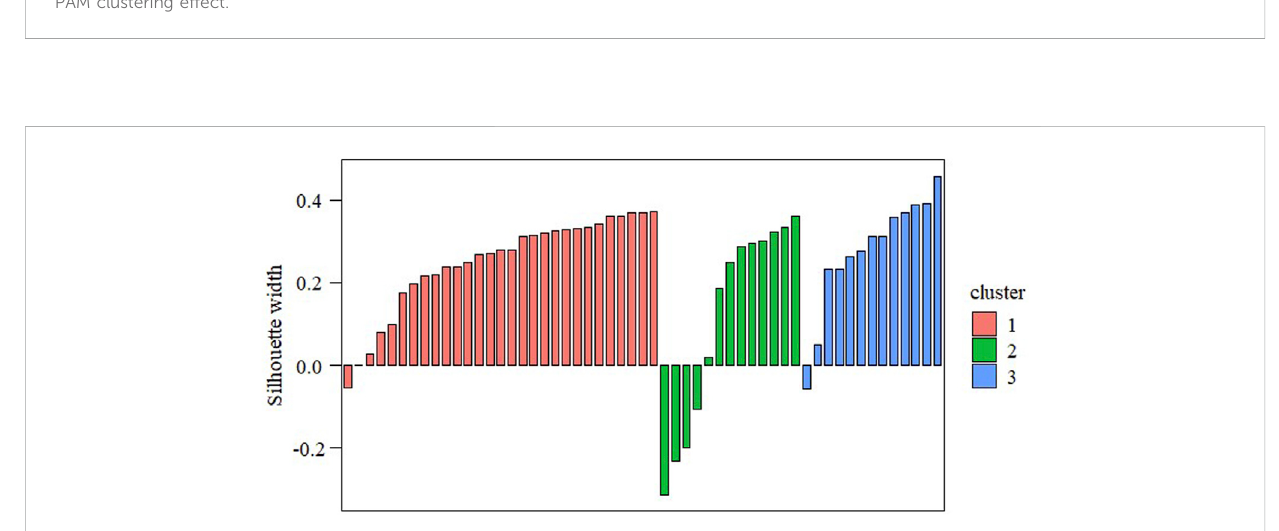
FIGURE 7 PAM clustering contour coef fi